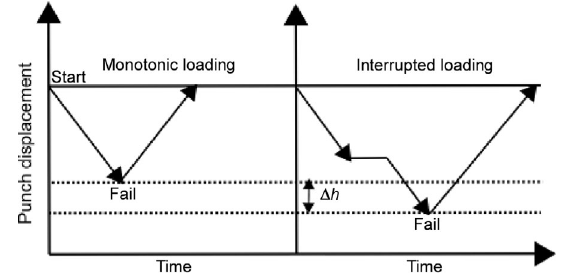
Fig. 2 Schematic diagram illustrating the punch travel in monotonic loading and interrupted loading (  h indicates the additional depth formed during interrupted